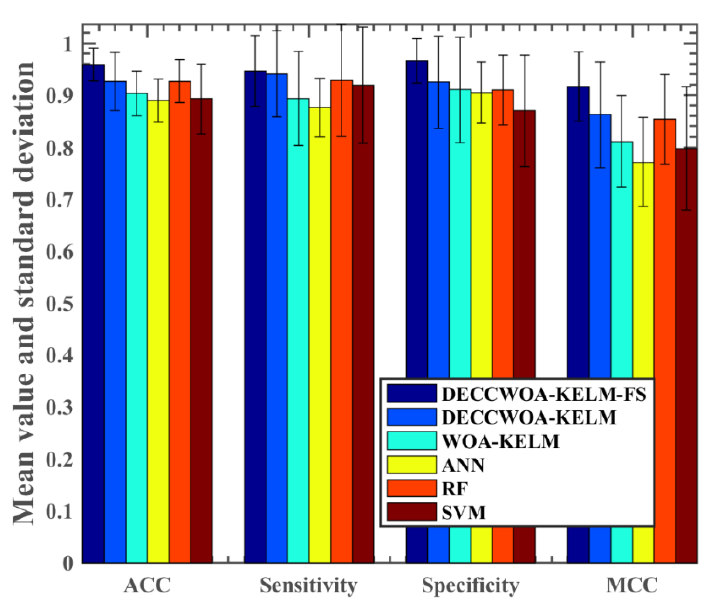
Figure 7. Mean value and standard deviation of four metrics for the DECCWOA and others methods.